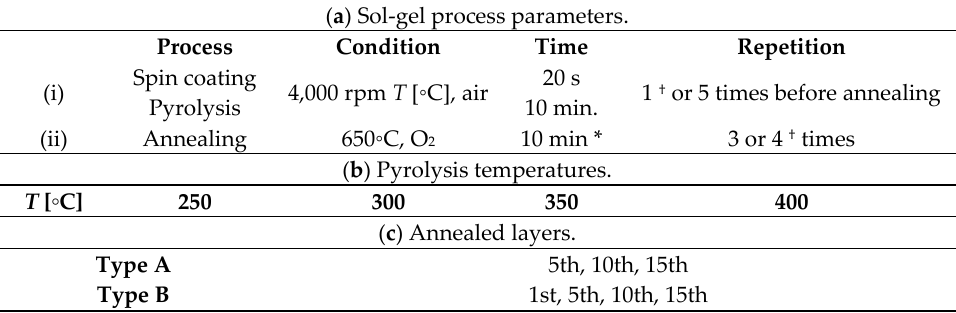
Table 1. Preparation conditions of sol-gel PZT